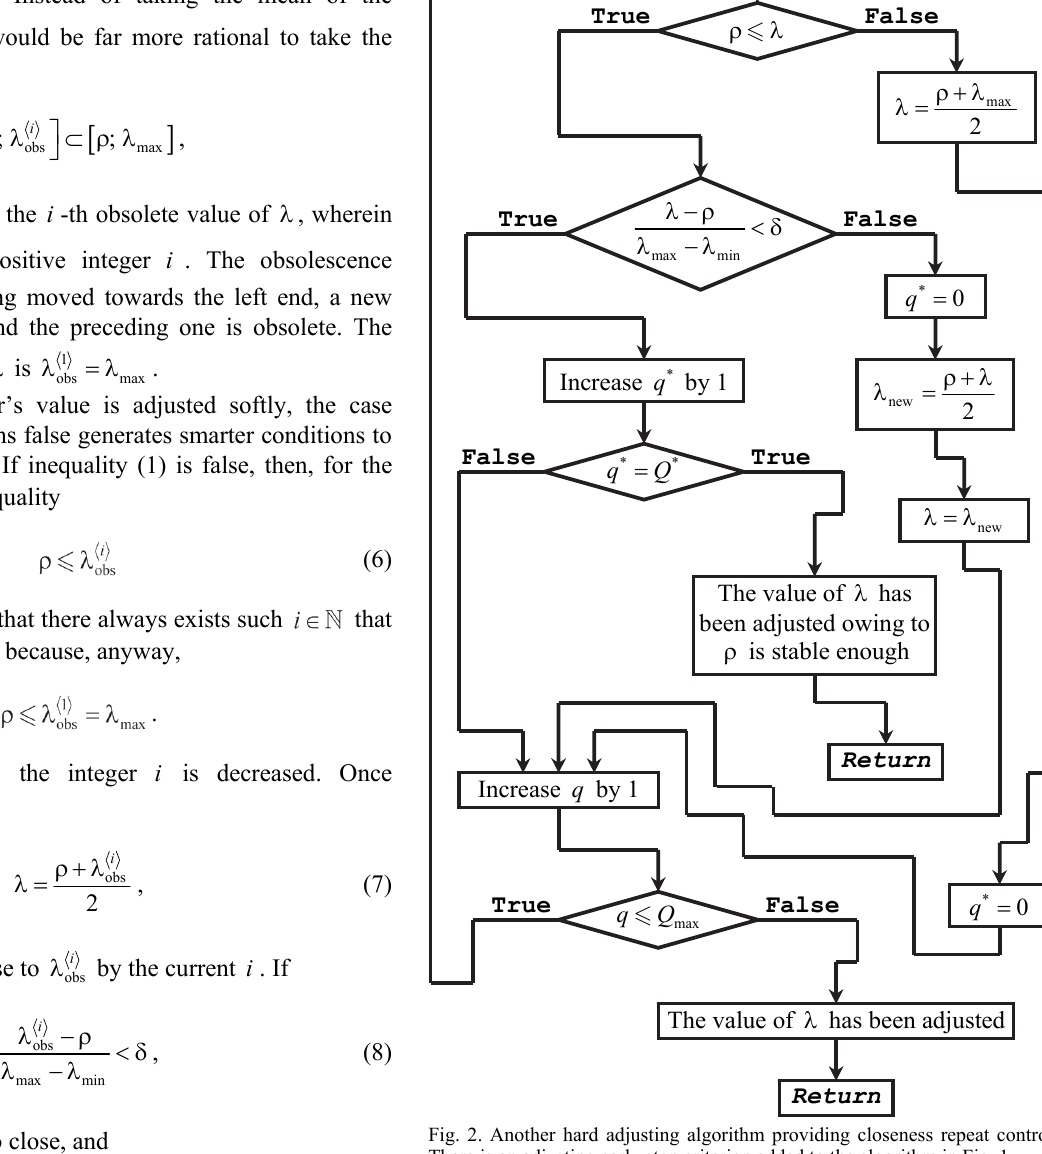
Fig. 2. Another hard adjusting algorithm providing closeness repeat control. There is an adjusting early stop criterion added to the algorithm in Fig.